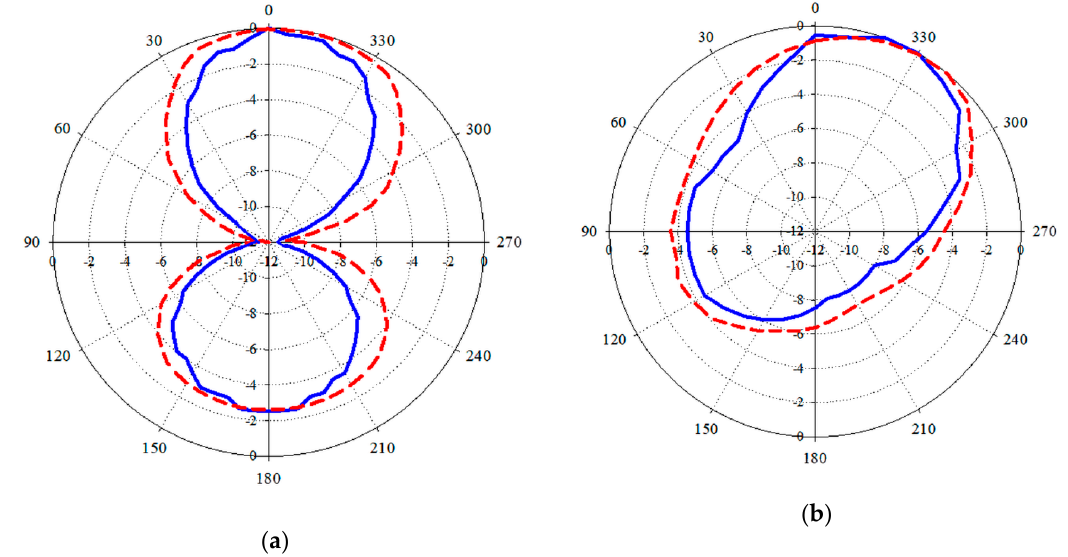
Figure 14. Simulated (red-dash) and measured (blue-solid) radiation patterns for the proposed tag attached to a tube full of blood (scales of the graphs are given in dB). ( a ) E-plane; ( b ) H-plane.